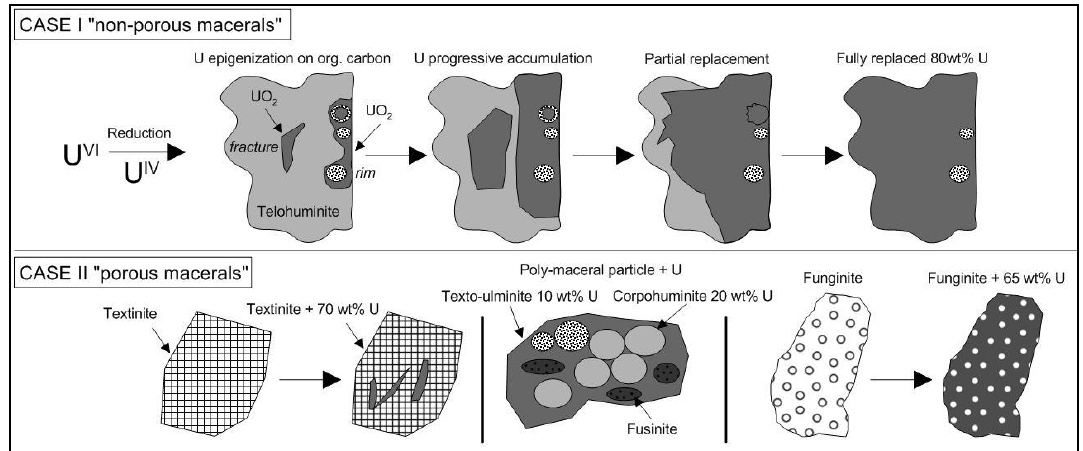
Figure 14. Graphical representation of organic matter epigenization by uranium. Uranium is carried in solution as U(VI) until it encounters a reducing agent and becomes U(IV). When uranium is reduced in the presence of macerals, it can be concentrated around internal fractures or at the rims of the maceral as uranium oxide. There is a linear decreasing concentration gradient from the rim where U is expressed as oxide towards the interior where no mineral form is visible. Eventually the replacement process keeps up, leading primarily to partial and progressively to full replacement (i.e., organic particles with up to 78 wt % U). One of the main aspects of this replacement process is that the fully replaced organic particle maintains its textural characteristics, although organic carbon is in very small quantities or no longer present.